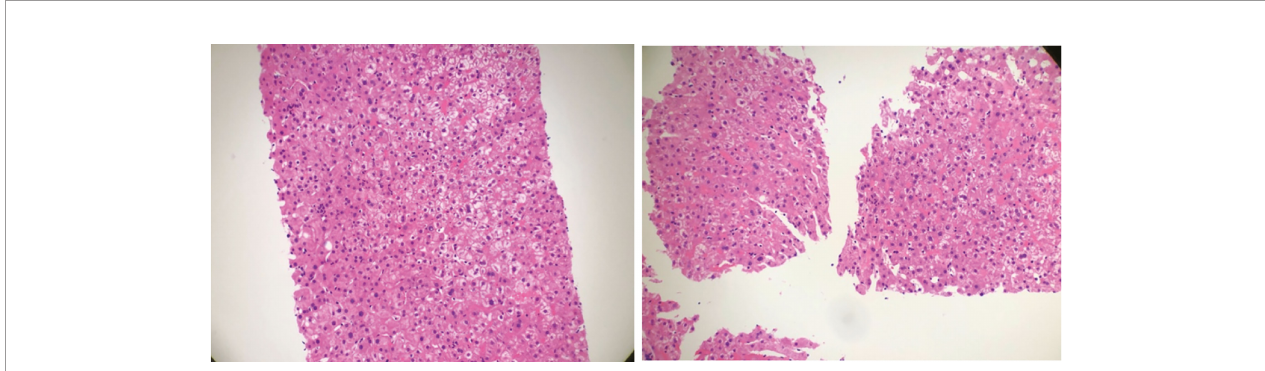
FIGURE 2 | Hematoxylin – eosin staining of liver biopsy. It showed that the structure of liver lobules was intact. Part of liver cells was turbid and swollen. Mild congestion and lymphocytes were seen in the liver sinusoids. Neutrophil aggregation was seen in small foci.